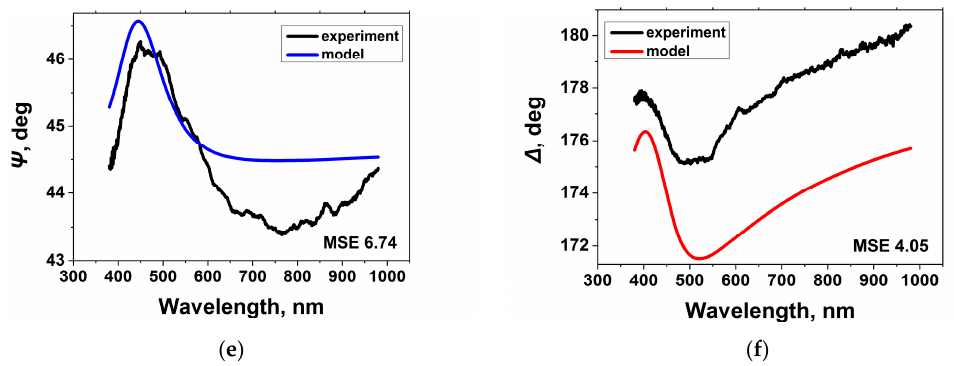
Figure 8. Comparison of the experimental (black) and theoretical dependencies of the ellipsometric angles Ψ (blue) and ∆ (red) on the wavelength at an angle of incidence of 20 ◦ for the samples: ( a , b ): h 1 —300 nm, h 2 —30 nm; ( c , d ): h 1 —600 nm, h 2 —30 nm; ( e , f ): h 1 —300 nm, h 2 —30 nm, T = 300 ◦ C (where h 1 —polymer thickness, h 2 —silver thickness, MSE—mean-square error).